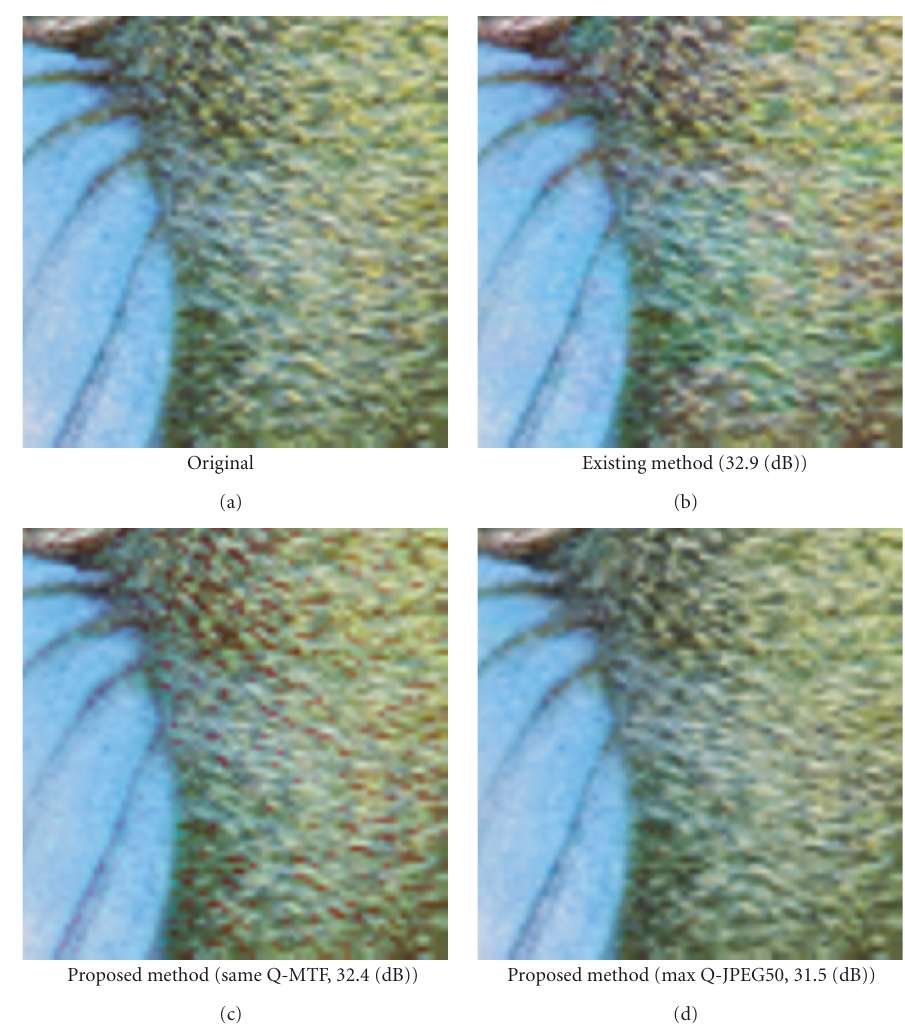
Figure 15: Comparison in the image quality by enlarged partial